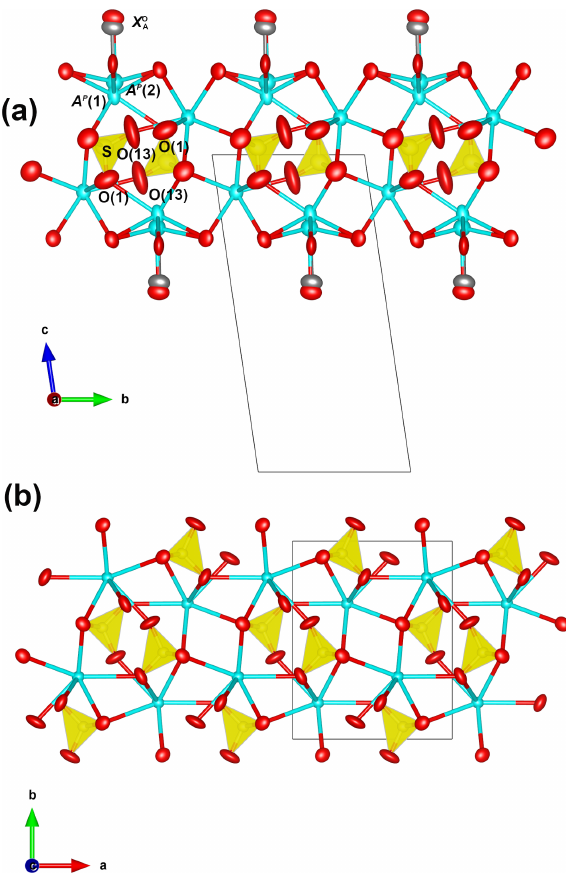
Figure 7. Comparison of the geometry of the intermediate block in zinkgruvanite (a) and a (010) slab of baryte (b) . Drawn with Vesta 3 (Momma and Izumi, 2011). Baryte model from Jacobsen et al. (1998).